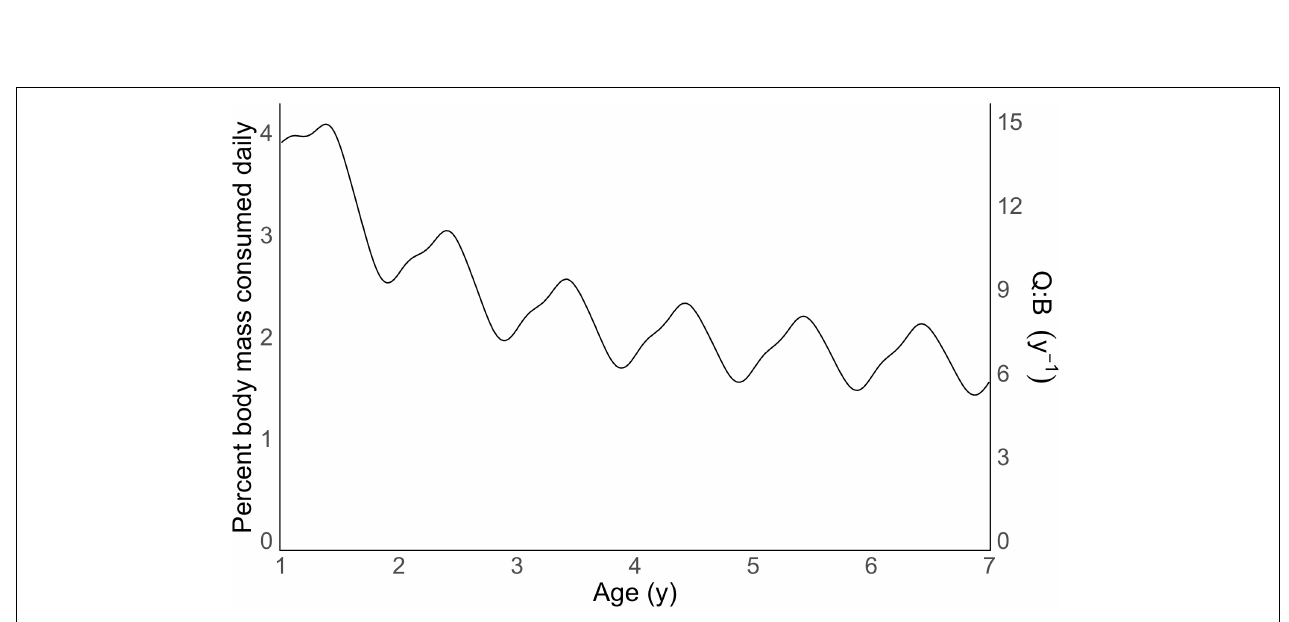
FIGURE 2 | The mean energy density of prey typically consumed by Yellowfin Bream (ED, n = 1,130 bream stomach contents) of sizes sampled in this study, in 1 mm bins. The solid blue line is the fitted LOESS curve (smoothing parameter = 0.75). The shaded area depicts the 95% confidence band.